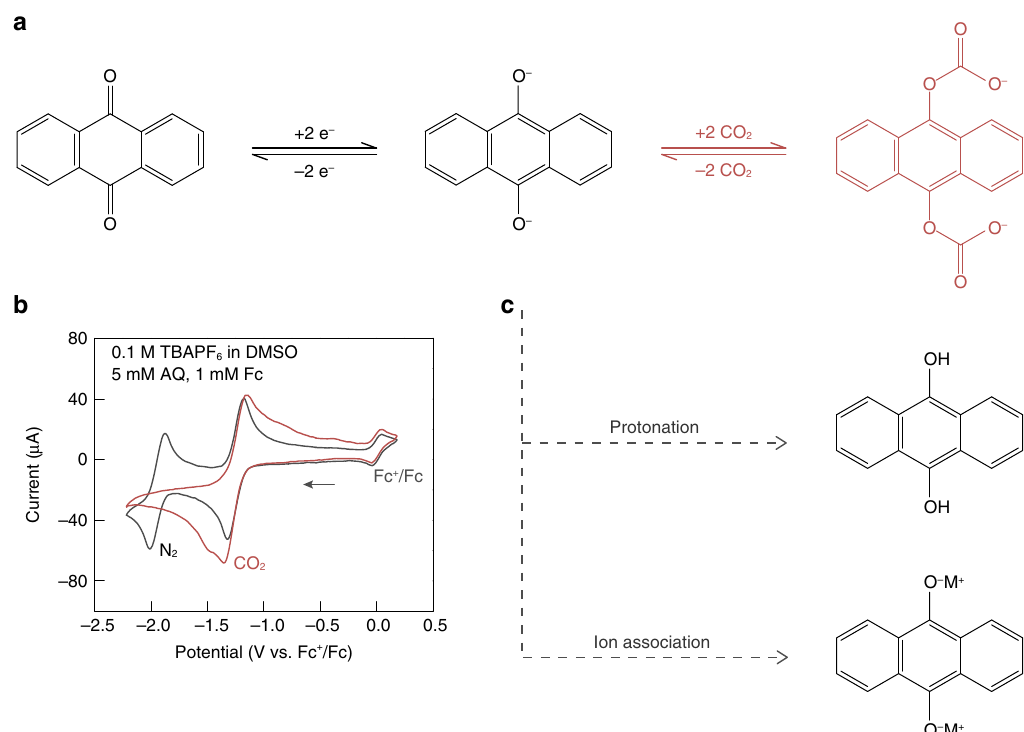
Fig. 1 Electrochemistry of quinone-mediated CO 2 capture. a The overall reductive addition reaction between CO 2 and AQ. b CV of AQ in an aprotic organic solvent with and without CO 2 . The CV scans were carried out in 5 mM AQ in dimethyl sulfoxide (DMSO) with 0.1 M tetrabutylammonium hexa fl uorophosphate (TBAPF 6 ) supporting salt. Glassy carbon was used as the working electrode, Pt wire as the counter electrode, Ag wire as a pseudo- reference electrode, and 1 mM ferrocene (Fc) as an internal reference. The scan rate was 50 mV s − 1 . c Major competing reactions when carrying out quinone-mediated CO 2 capture in aqueous